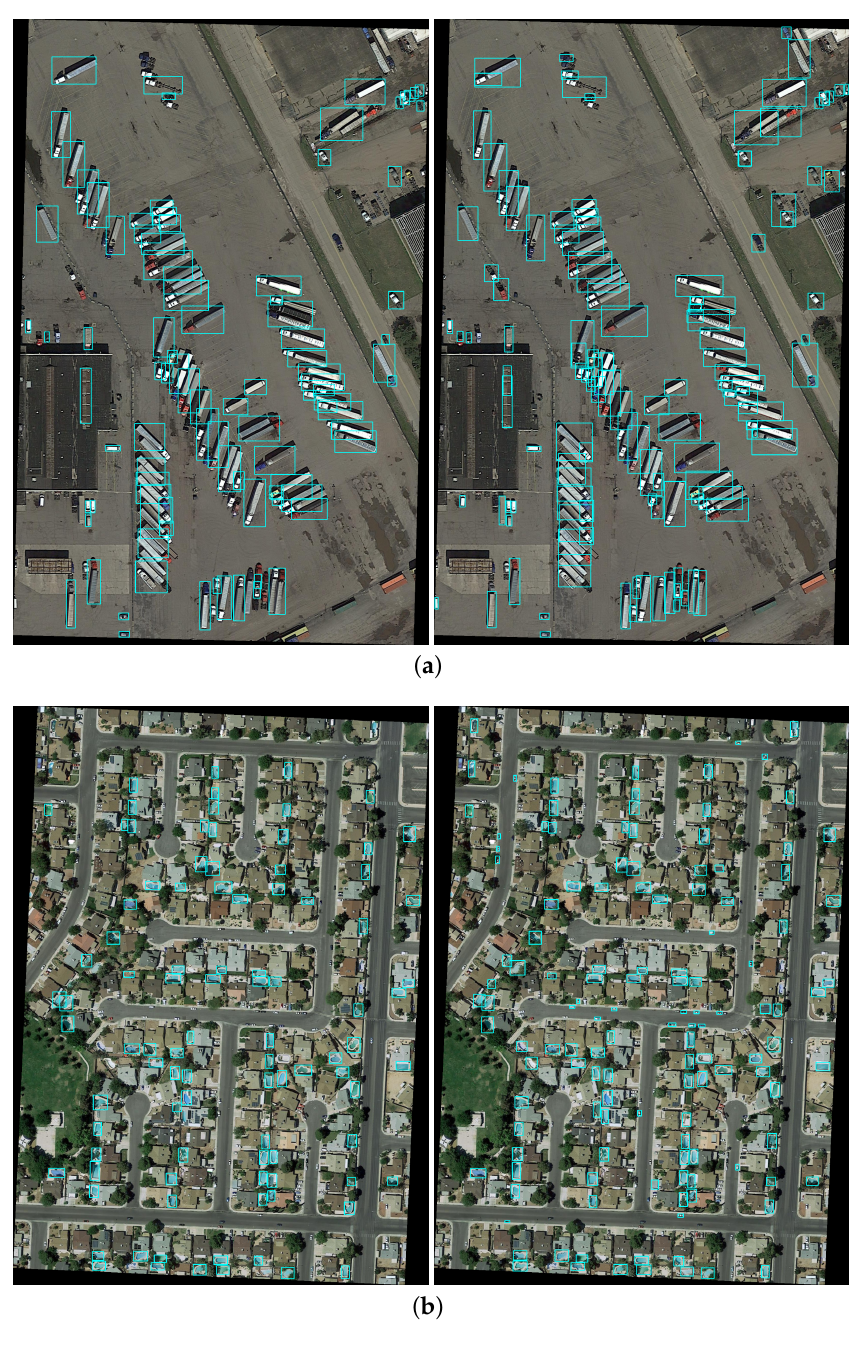
Figure 10. Selected visual comparison of DOTA benchmark dataset. Each subfigure include result of Libra RCNN on the left and MB-RPN on the right. ( a ) small objects ( b ) middle